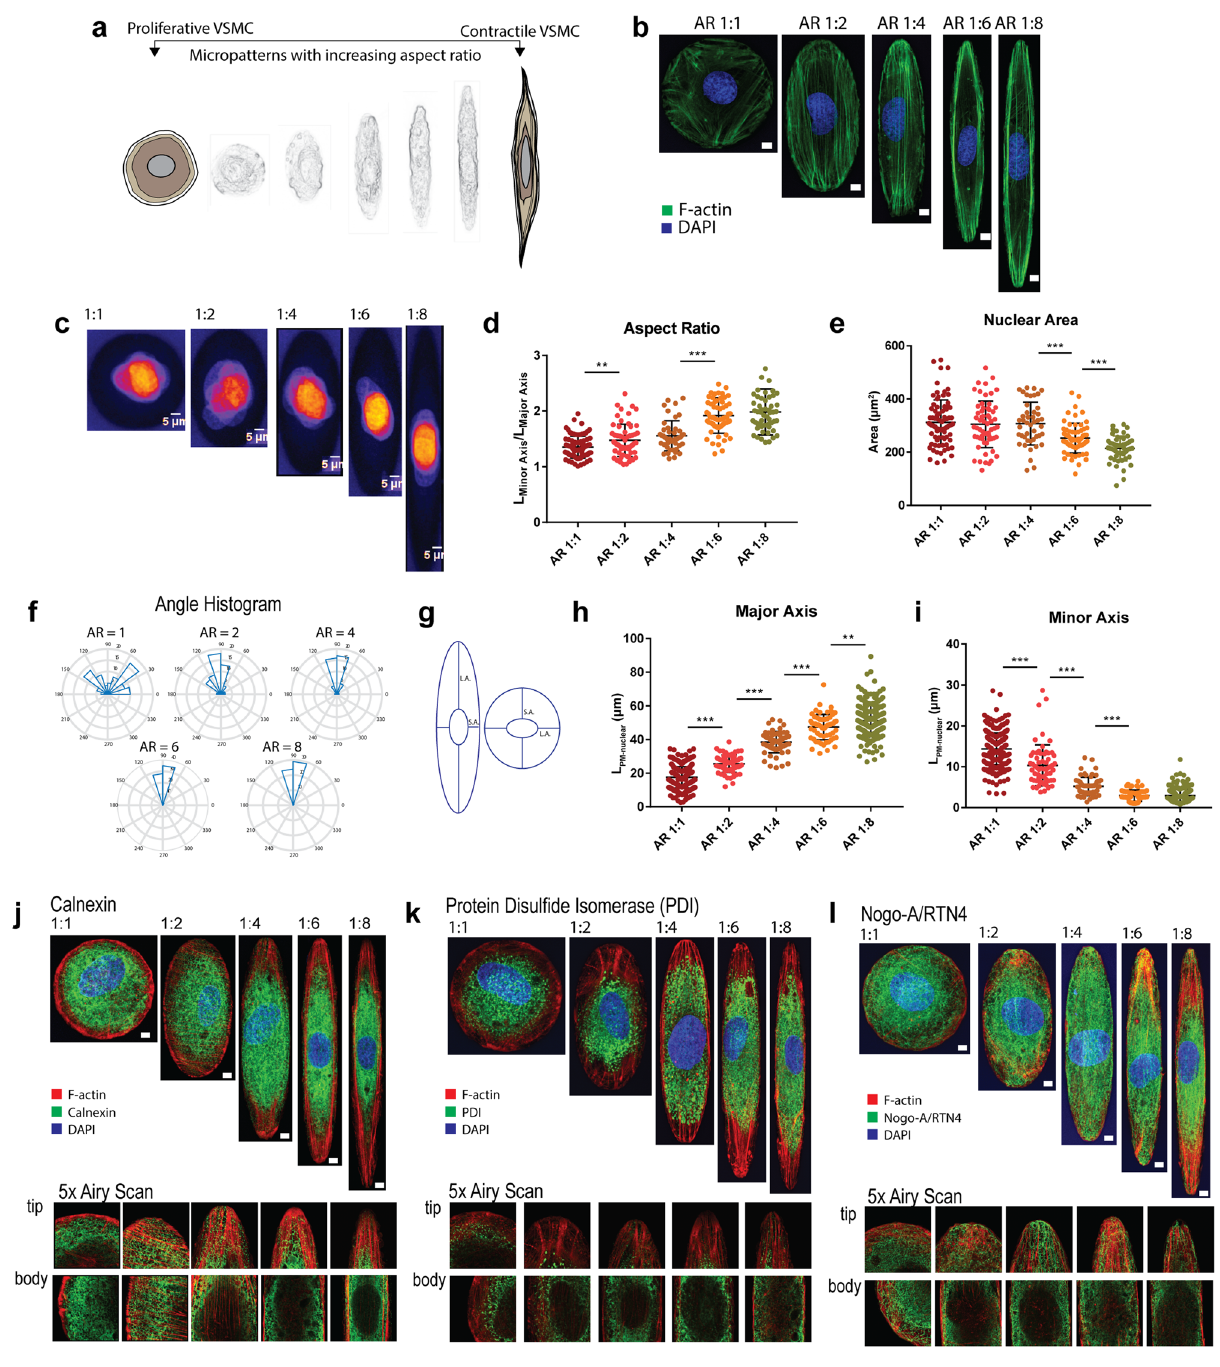
Figure 3. Cell shape impacts cytoskeletal organization and organelle location. Whole cell shape changes location and distribution of subcellular organelles in a systematic manner. ( a ) Biomimetic, microfabricated surfaces with graded aspect ratios fine-tune the shape of VSMC and its enclosed organelles. ( b ) Actin organization is dependent on cell shape. ( c ) Cell shape affects nuclear shape, size and distance to PM. Representative images of VSMC compliant in patterns with increasing AR stained for DAPI. Scatterplots of whole aspect ratio versus ( d ) nuclear aspect ratio ( e ) size (area µm 2 ) ( f ) orientation with respect to the major axis of the cell ( N AR1:1 = 82 , N AR1:2 = 60 , N AR1:4 = 45 , N AR1:6 = 65 , N AR1:8 = 54 ). (g) Relationship between whole cell shape and PM-nuclear distance was determined by segmenting cell and nuclear boundaries with Actin Green and DAPI respectively. Distances between nuclear and plasma membrane boundaries were measured along the long and short axes of the nucleus. ( h ) Increasing the cellular aspect ratio increases the distance between the nucleus and the plasma membrane in the major axis of the cell while ( i ) decreasing the PM-nuclear distance in the minor axis of the cell (** p ≤ 0.05, *** p ≤ 0.0001, two-tailed t-test). ( j – l ) SR distribution in VSMC seeded in AR 1:1 to 1:8 staining for SR membrane markers (panels below show 5 x magnified Airy scan images of tip and body of images shown) ( j ) calnexin ( k ) protein disulfide isomerase (PDI) and ( l ) reticulon-4. Scale bars shown are 10